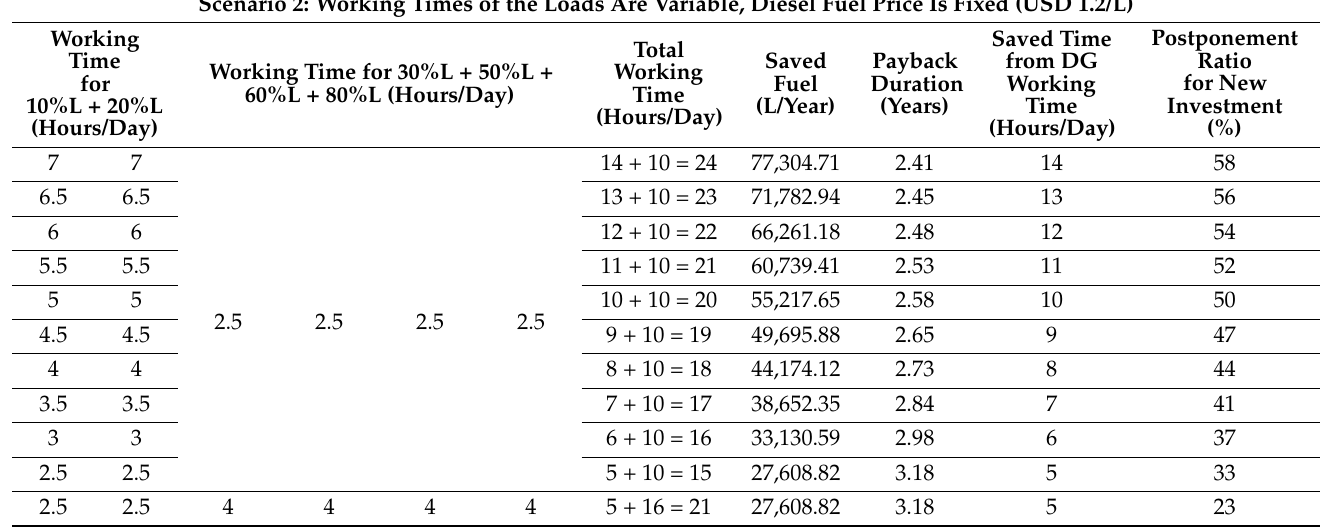
Table 3. Payback time with varying working hours (scenario